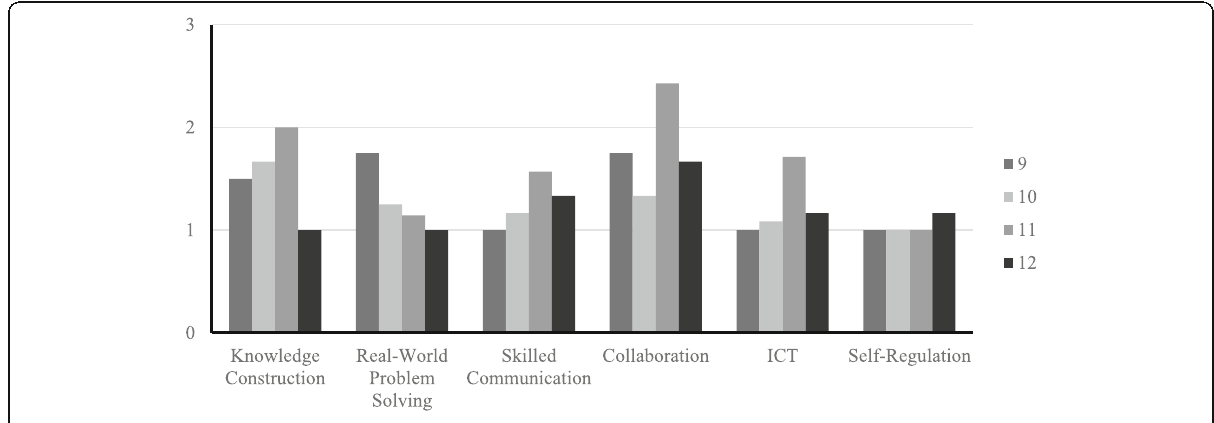
Fig. 4 The average rubric metric scores for short-term lessons, sorted by grade level for the